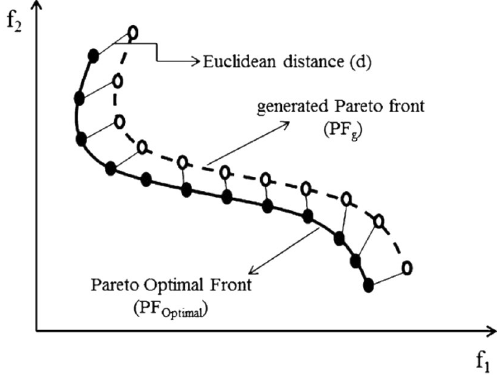
Figure 3. Schematic of the GD metric for MOPs 35 .